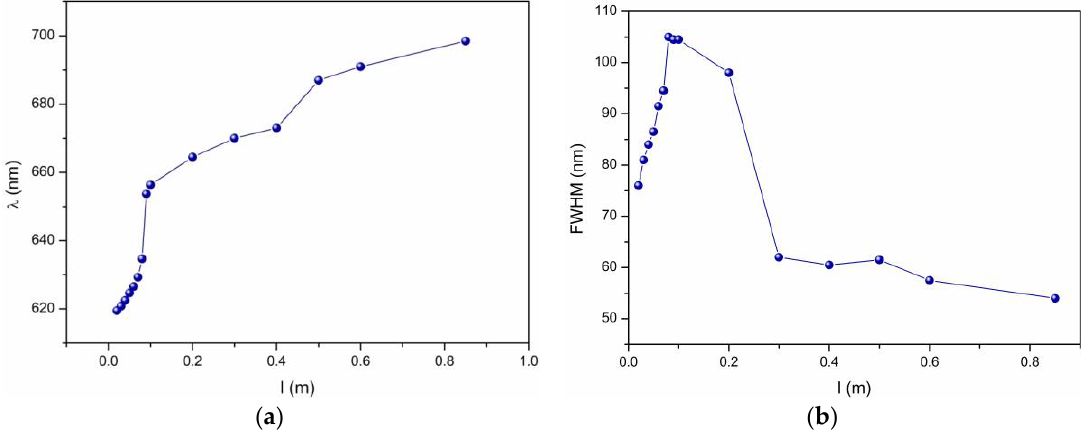
Figure 5. ( a ) The λ max shift vs. fiber length, ( b ) The FWHM of luminescence spectrum vs. fiber length.